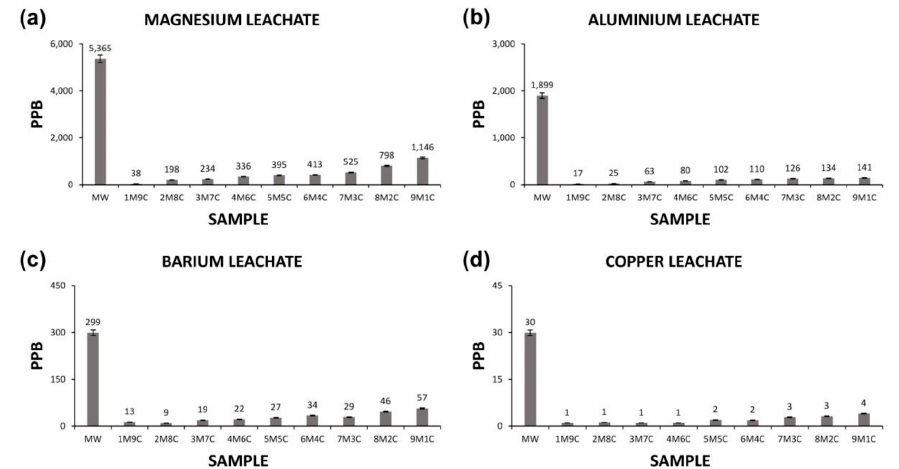
Figure 8. Leaching tests of chemical elements contaminating for the ceramic families with clay and mining residue and the unaltered mining residue sample. ( a ) Magnesium leachate, ( b ) Aluminium leachate, ( c ) Barium leachate and ( d ) Copper leachate.